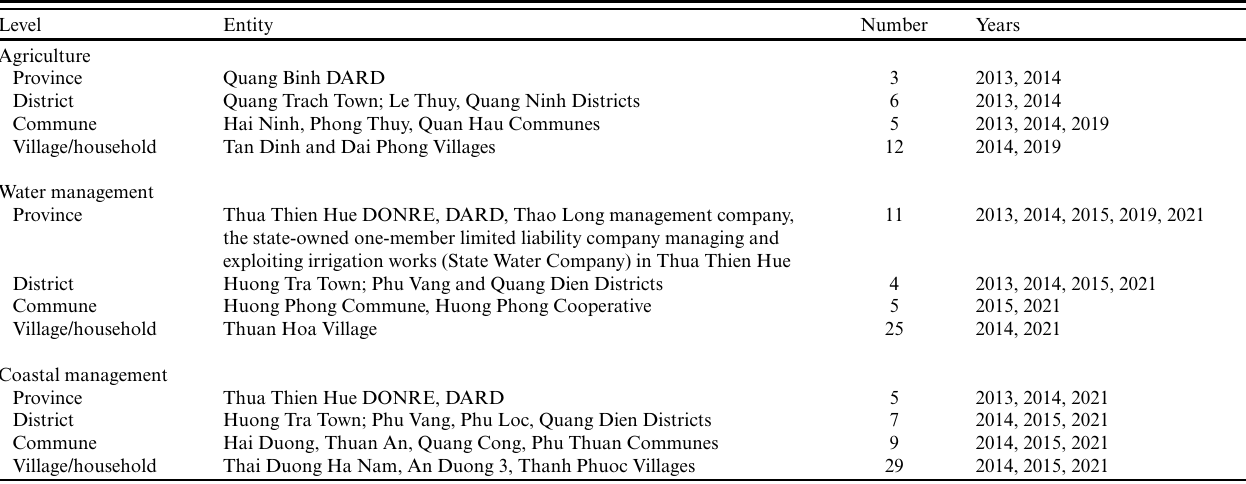
Table 1. Interviews conducted. DARD, Departments of Agriculture and Rural Development; DONRE, Departments of Natural Resources and